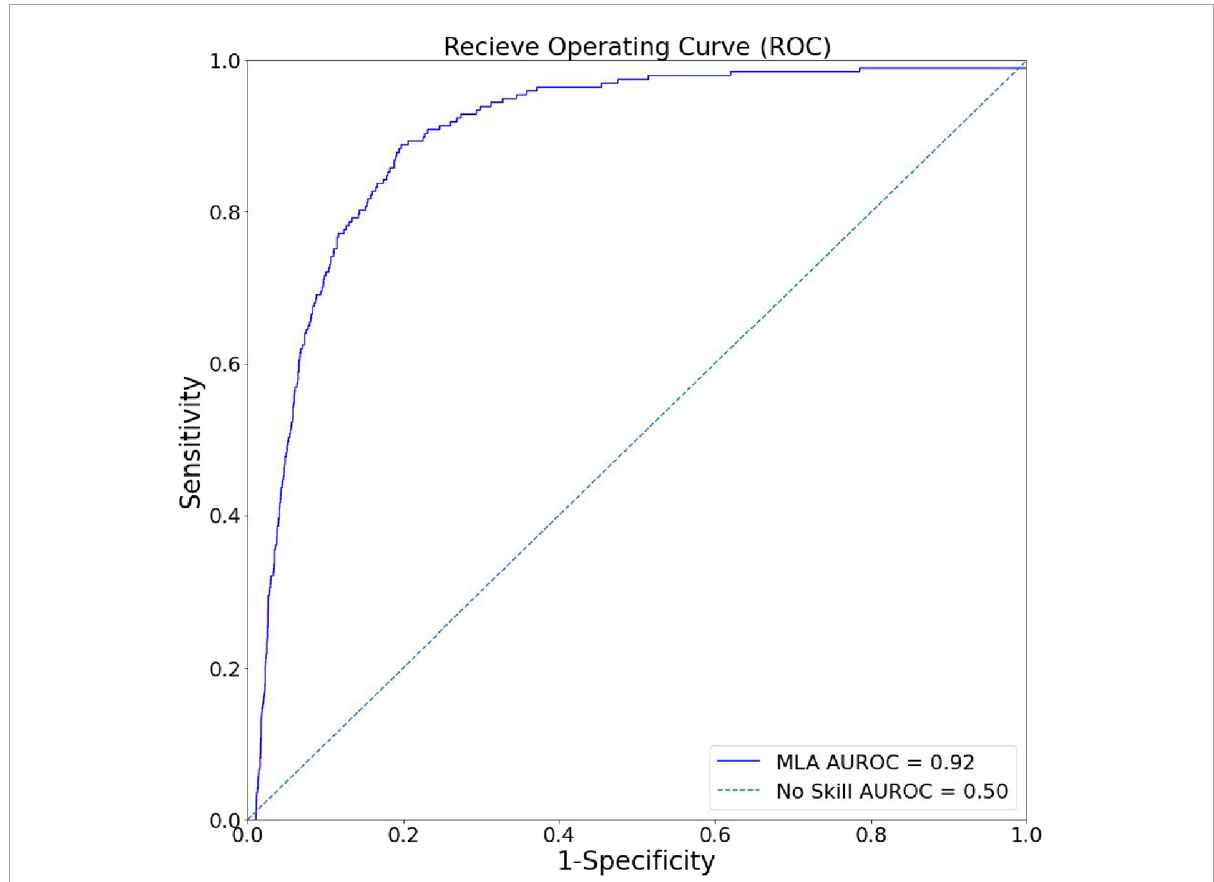
FIGURE2 Algorithm discrimination and precision in identifying hospital encounters with future positive RSV tests. The receiver-operating curve (ROC) for the XGBoost model, showing superiority to random chance (gray) in discrimination between RSV-positive and non-RSV-positive encounters.